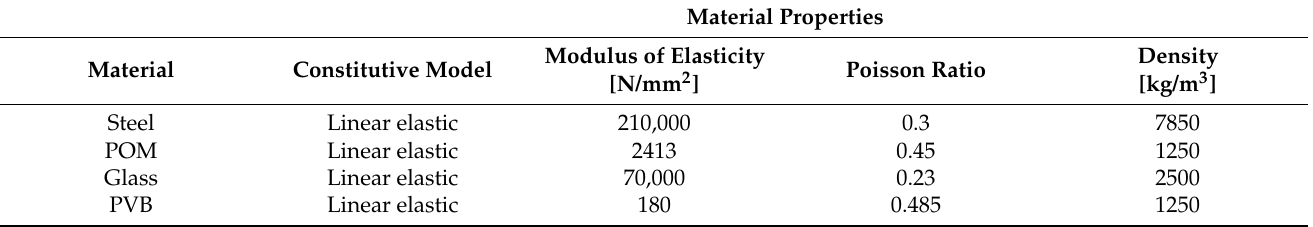
Table 2. Summary of the mechanical properties for materials in use in the Refined numerical